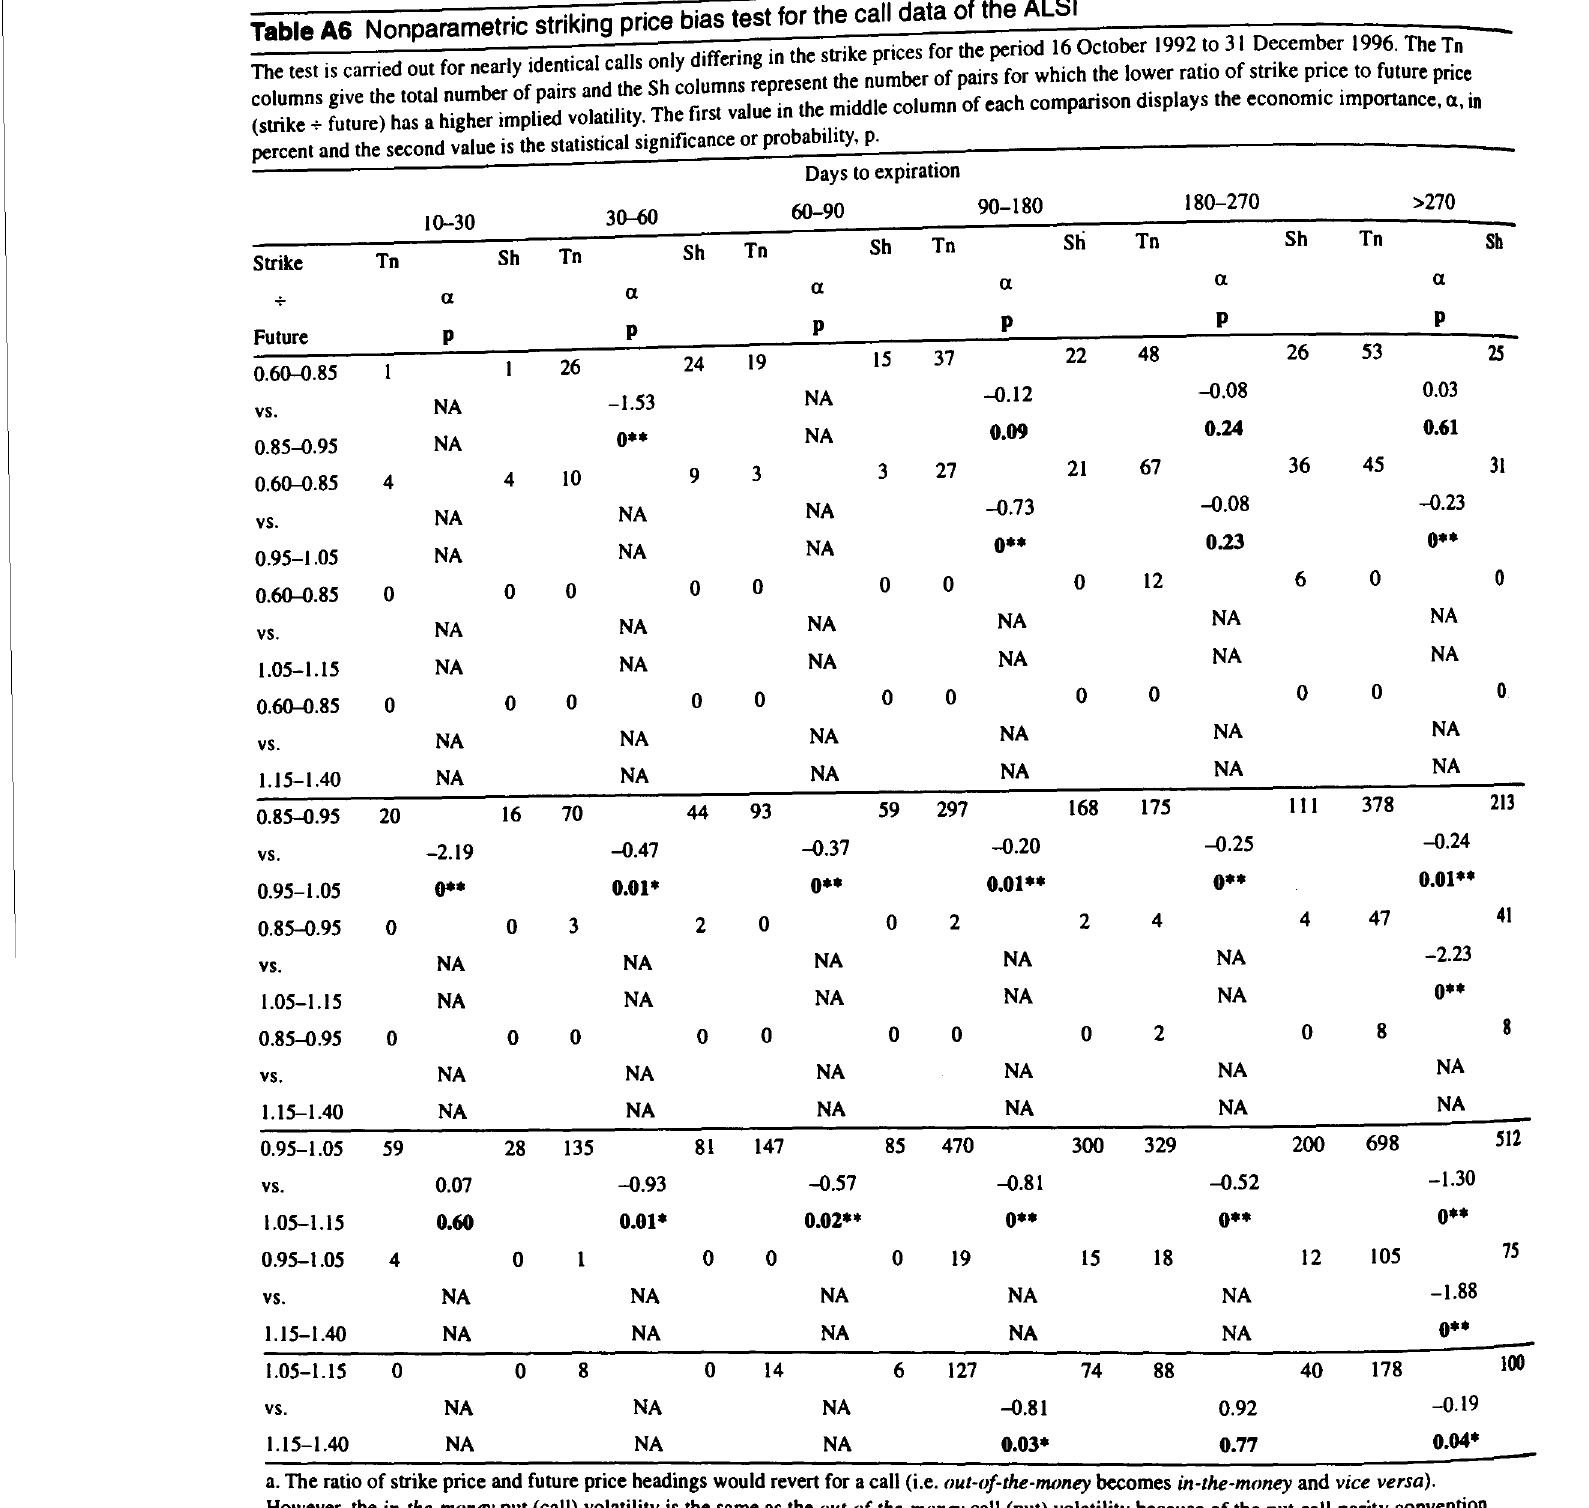
Table A6 Nonparametric striking price bias test for the call data of the_ALSI .